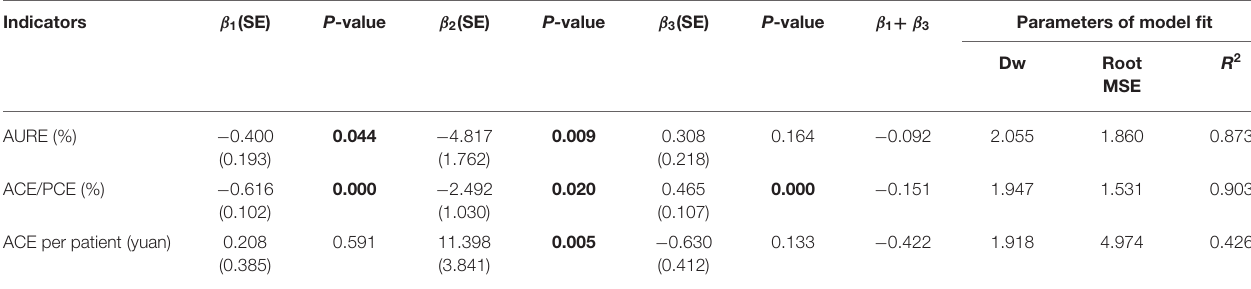
TABLE 8 | ITS analysis of antibiotic use in emergency patient. Indicators